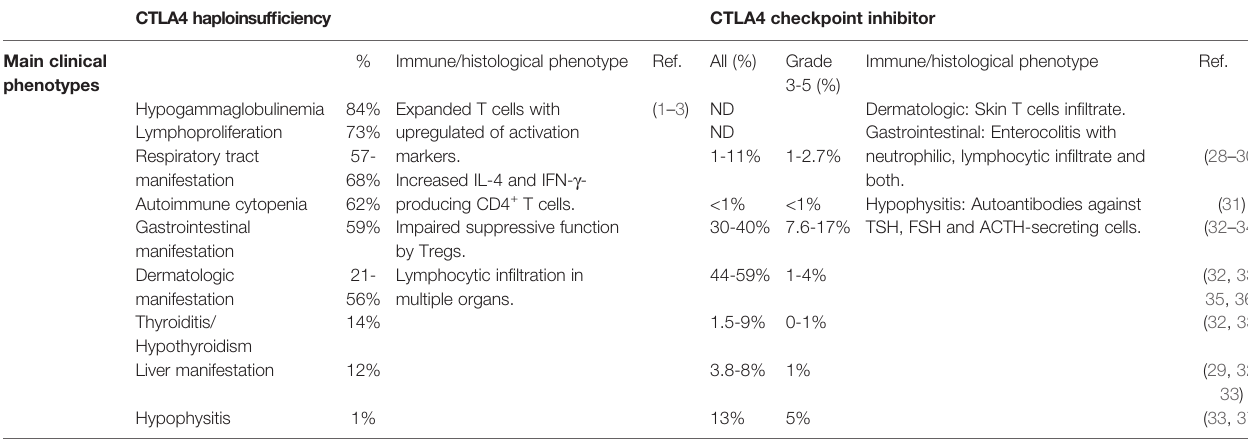
TABLE 1 | Inborn errors of CTLA4 and their phenocopies.